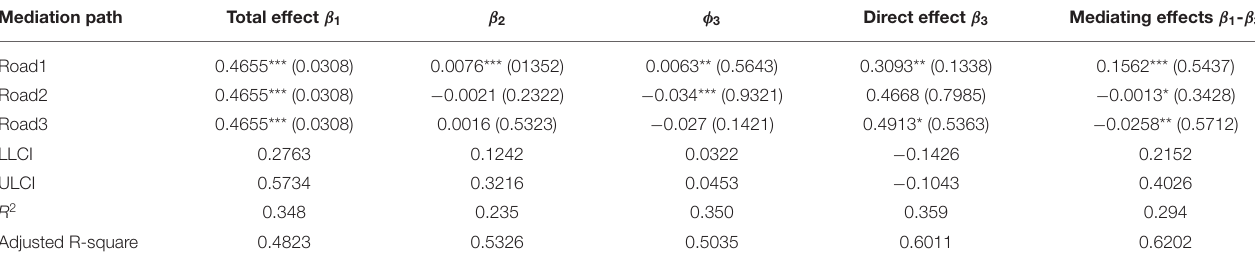
TABLE 3 | Estimation results of chain mediating effect.